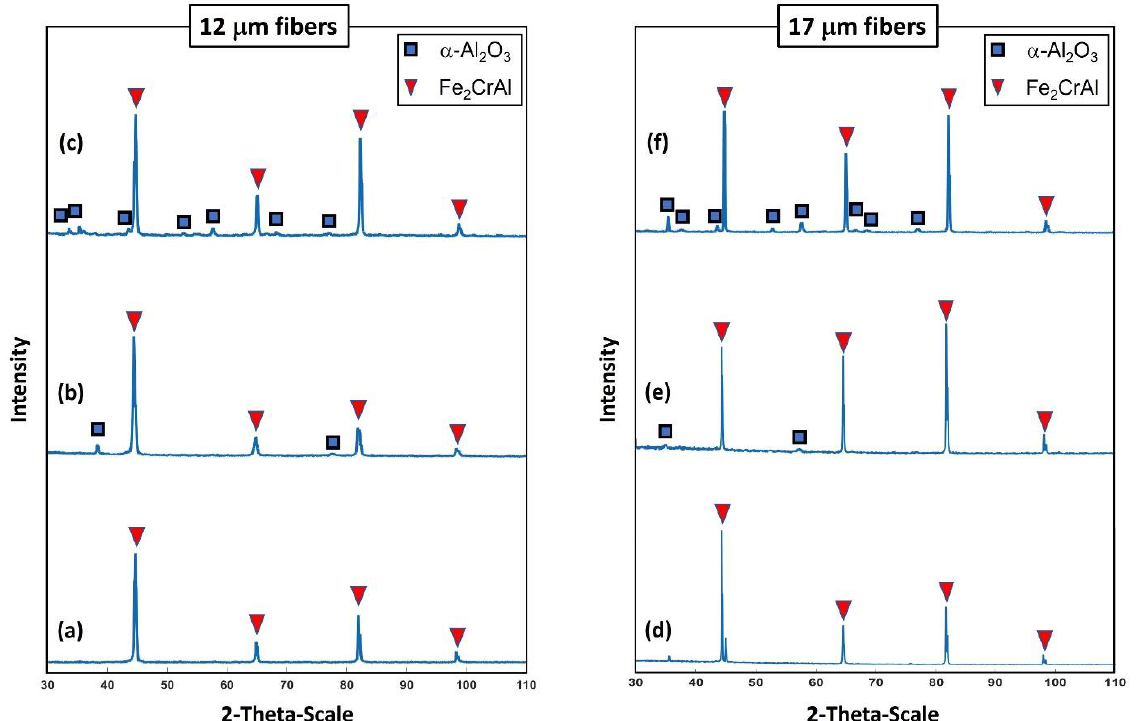
Figure 20. XRD test shows the crystalline pattern: For the 12 µ m fibers, ( a ) without heat treatment, ( b ) after one MSHT cycle, and ( c ) after 18 MSHT cycles. For the 17 µ m fibers, ( d ) without heat treatment, ( e ) after one MSHT cycle, and ( f ) after 18 MSHT cycles.